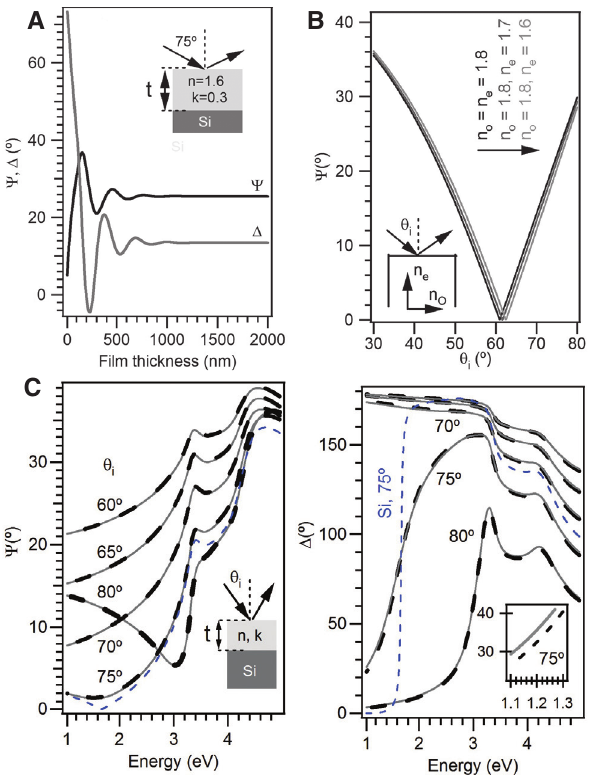
Figure 2 Some examples of spectroscopic ellipsometry analysis – parameter sensitivity and correlation between parameters. (A) Ellip- sometric angles versus the thickness t of a thin film (n = 1.6, k = 0.3) = 75 ° and a wavelength in on a Si substrate, at an incident angle θ i vacuum λ of 800 nm. (B) Ψ versus θ for an isotropic crystal (n = 0 i